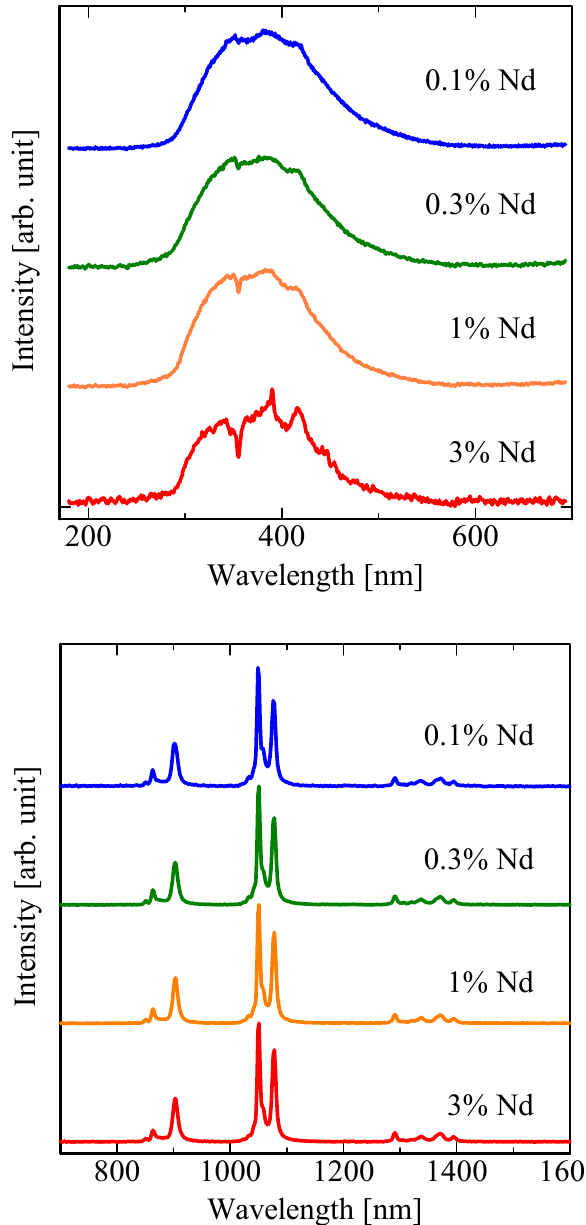
Figure 5. X-ray-induced emission spectra of LaMgAl 11 O 19 :Nd in the UV–visible ( top ) and NIR range ( bottom ).